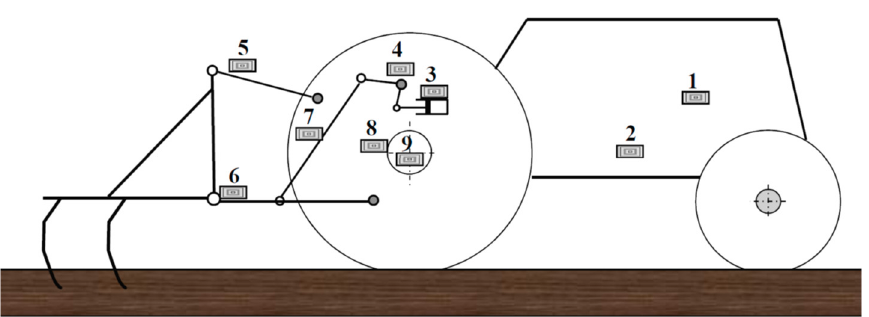
Figure 2. The scheme for placement of measurement sensors on the machine unit: 1—Flowtronic 215 fuel gauge; 2—II DICKEY-JOHN radar; 3—P8AP pressure converter; 4—LVDT implement linkage position sensor; 5—tensometer for measuring force in the upper linkage bar; 6—elastomagnetic sensors for measuring longitudinal forces in lower linkage bars (left and right); 7—tensometers for measuring forces in hangers (left and right); 8—PCID-4 ZN induction sensors of drive wheel angular velocity (2 pcs); 9—tensometers to measure torques of drive wheels (left and right).